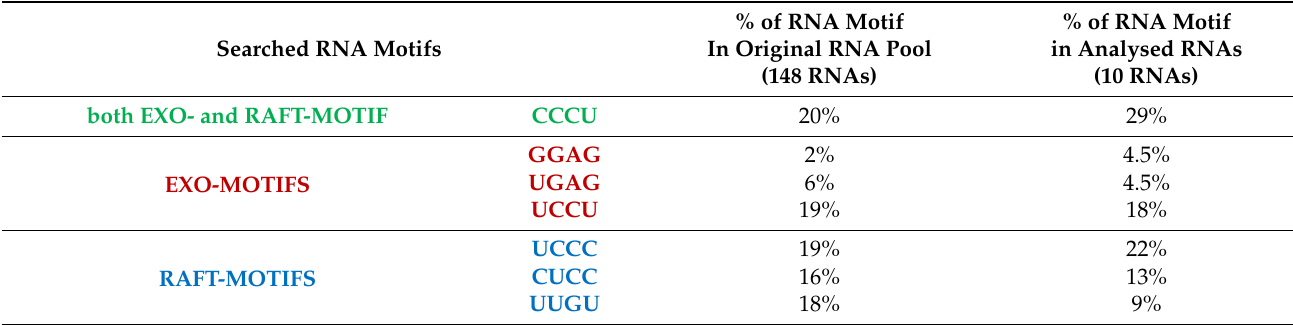
% of RNA Motif in Analysed RNAs (10 RNAs)